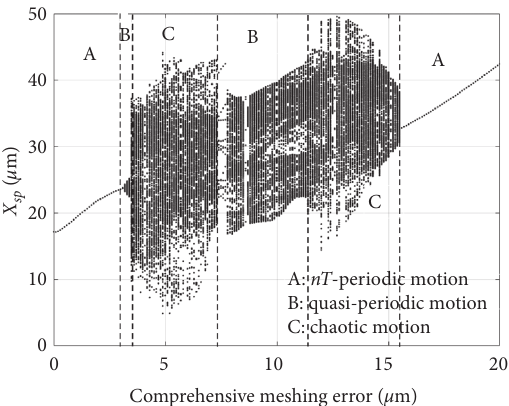
Figure 13: Bifurcation diagram of system with varying comprehensive meshing error.